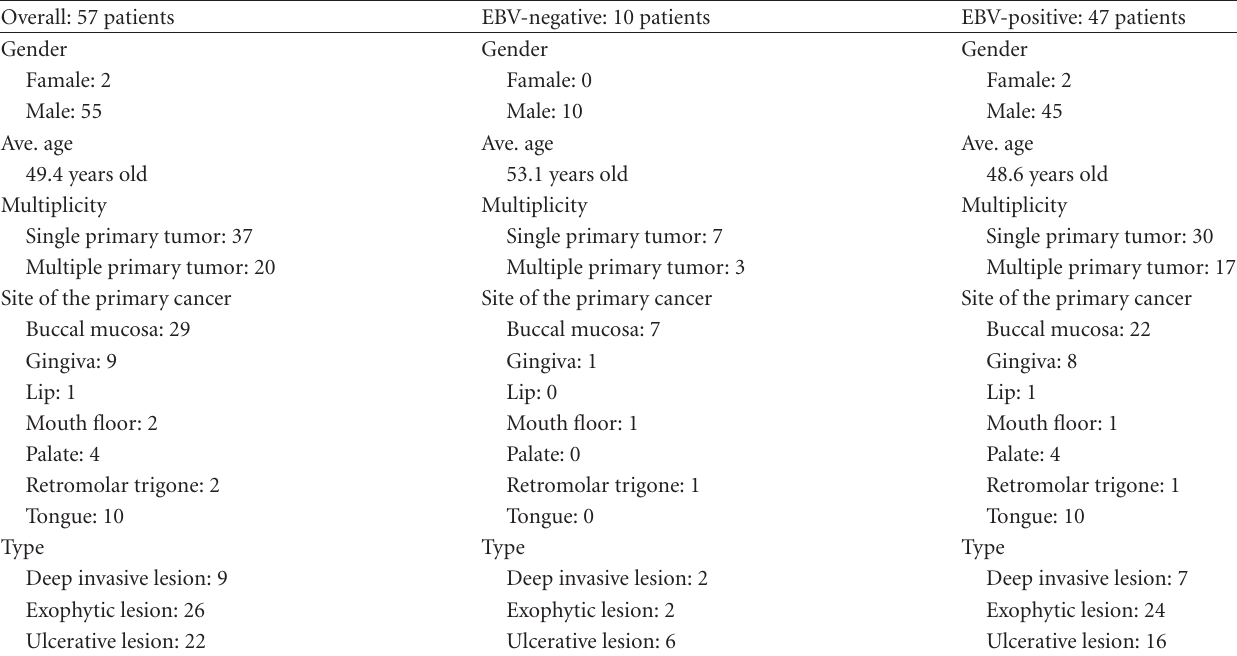
Table 2: Summary of the clinical characteristics of the studied patients.